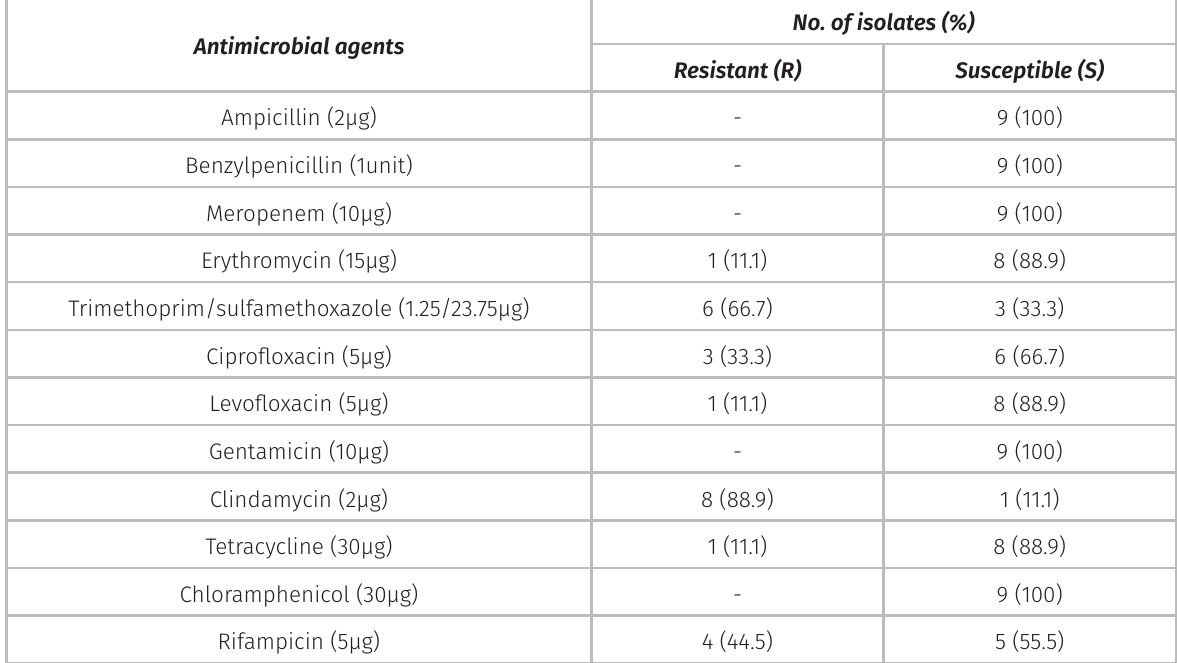
Table III. Antimicrobial susceptibility profile of L. monocytogenes isolates from serrano artisanal cheese.